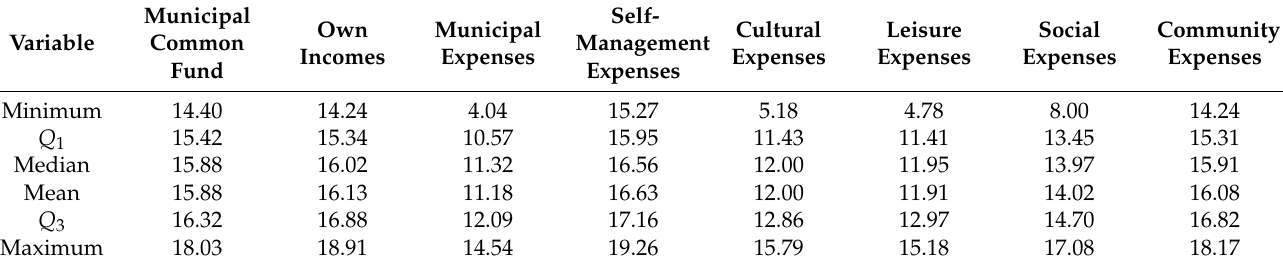
Table 4. Municipal expenses and public budget summary